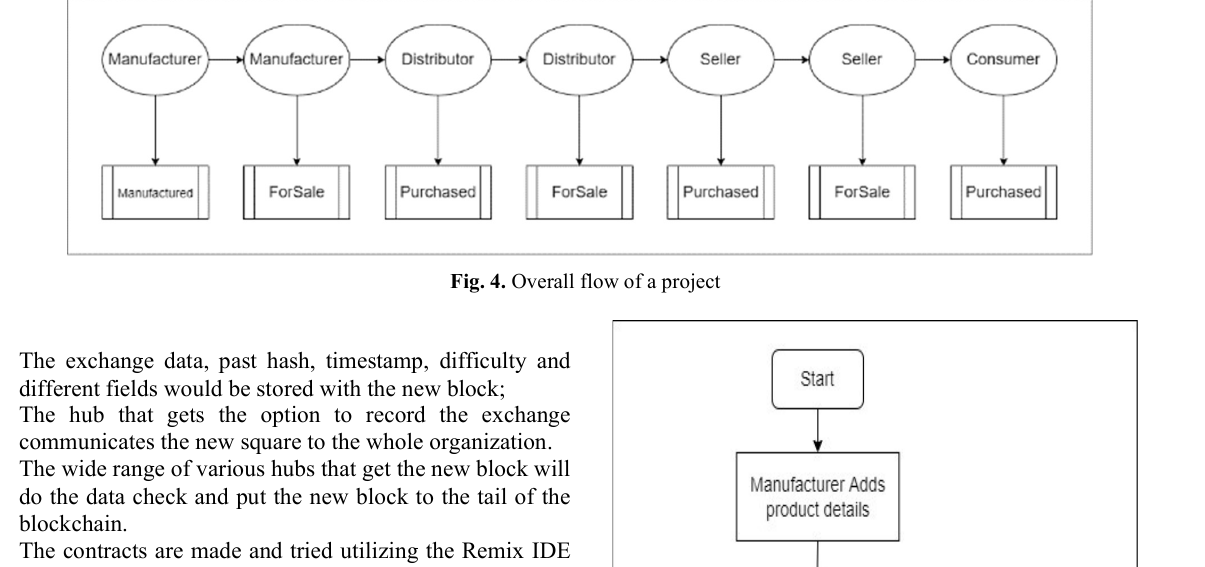
Fig. 3. General Implementation of System